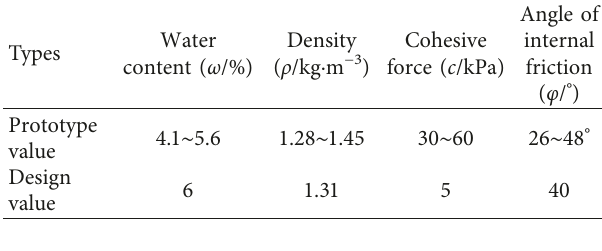
Figure 2: The large shaking table.